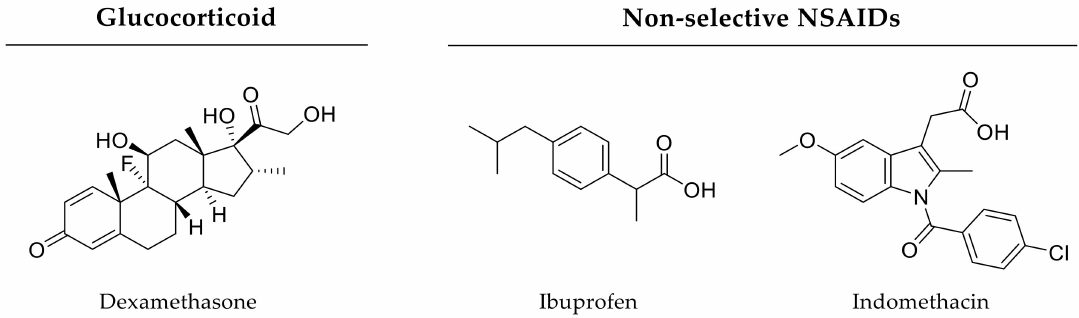
Figure 8. Chemical structures of selected anti-inflammatory drugs. Both glucocorticoids and NSAIDs are inflammation-modulatory small molecules inhibiting cyclooxygenase isoforms and prostaglandin production. These drugs mainly impair bone repair, as prostaglandins are crucial during early bone healing